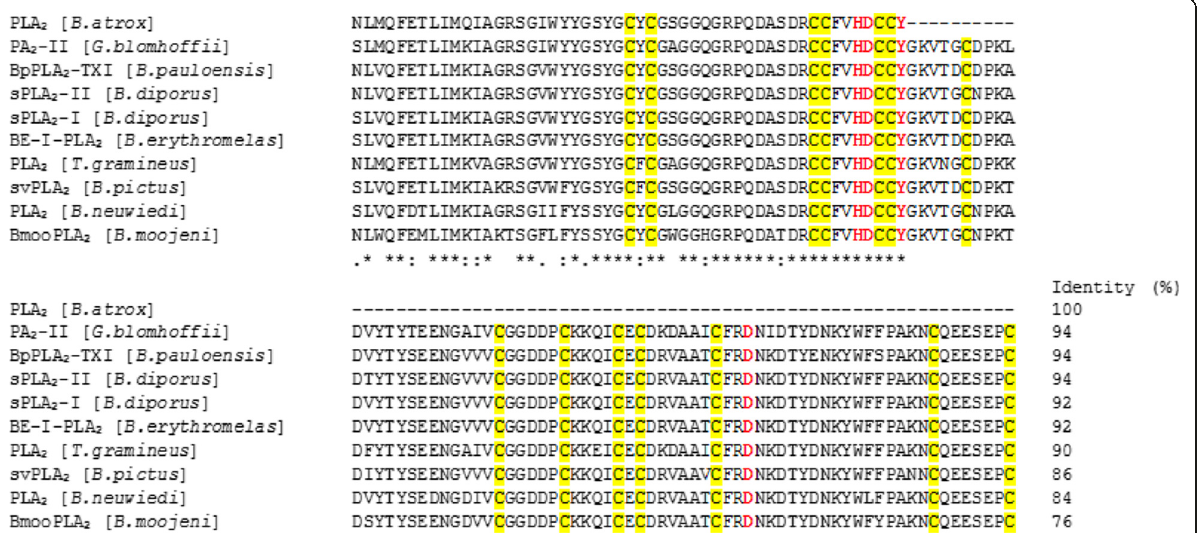
Fig. 10 Multiple alignment of the N-terminal sequence of the PLA 2 from B. atrox venom with other acidic PLA 2 s from snake venoms. The highlighted amino acid residues are part of disulfide bonds (yellow) and the catalytic site (red). GI numbers (from top to bottom, respectively): 129420, 528050010, 387537880, 387537878, 123907441, 3914270, 23396779, 458601843 and 403399514. (*) indicates positions with fully conserved amino acid residues; (:) indicates conservation of the following groups with high score: K/R/Q/H, S/A, K/N/D, F/L/V/I, E/D/N/Q, T/S/A, I/M/L; (.) indicates conservation of the following groups with lowest score: N/R/G, G/D/N, A/V/T, Q/K/E/R, S/K/G/A, D/K/H, C/S, T/P